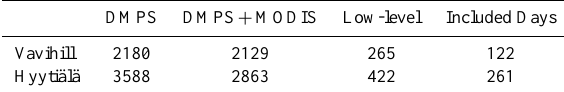
Table 2. The number of days included in each step of the data anal- ysis for the two stations. The first column shows the number of days with DMPS data, the second column the number of days with DMPS data and simultaneous MODIS satellite scenes, the third col- umn the number of days with low-level clouds manually detected in the satellite scenes and the fourth column the number of days in- cluded in the